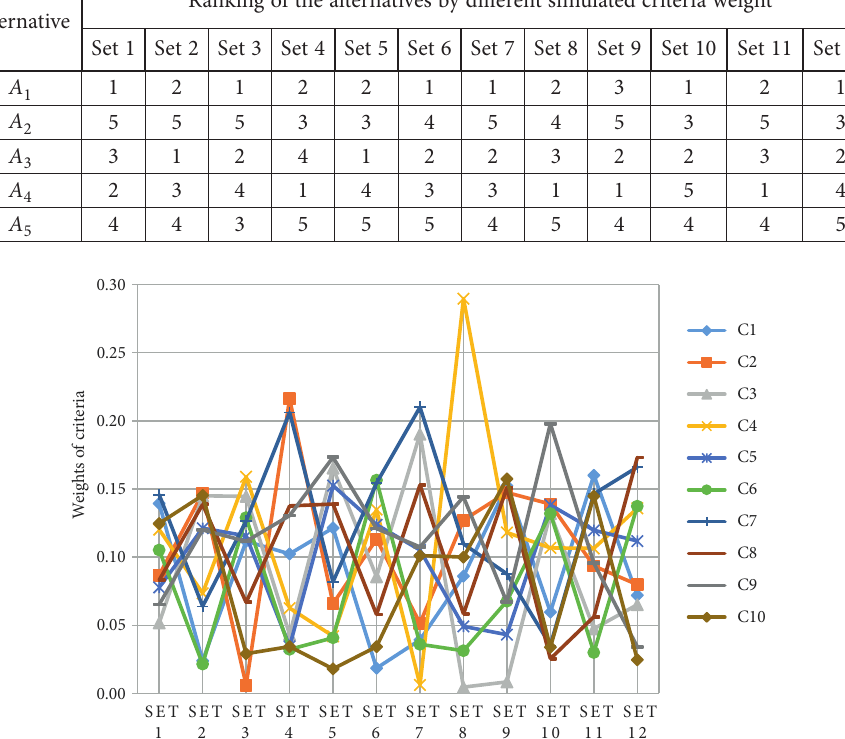
Figure 7. Ten sets of the criteria weights for sensitivity